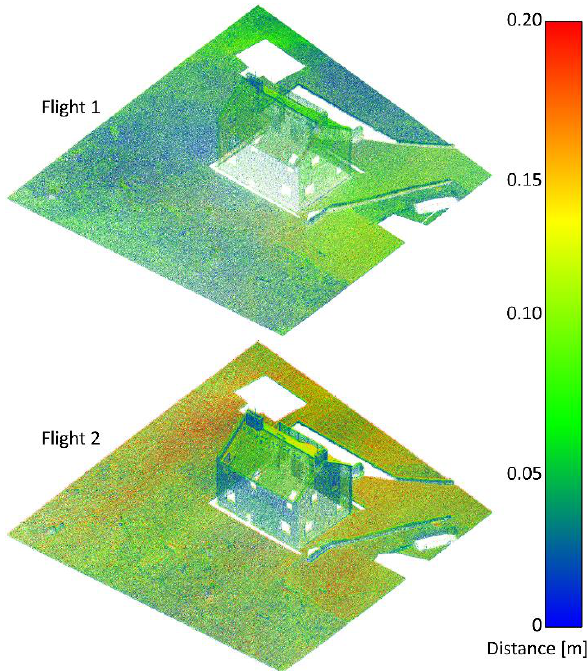
Figure 8. 3D distances between LiDAR UAS and reference TLS points. Occluded areas were removed from the